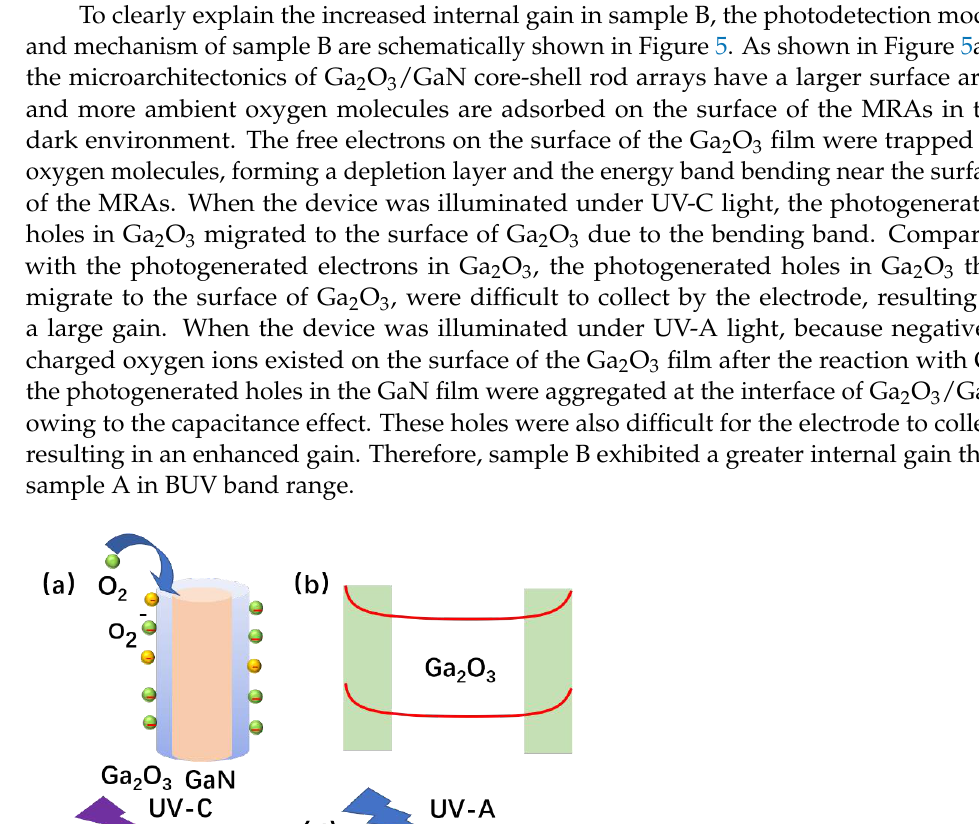
Figure 5. ( a , b ) Schematic of reaction of Ga 2 O 3 /GaN core-shell micron rod with oxygen and band of Ga 2 O 3 films after reaction with oxygen respectively ( c ) Schematic of holes transferred to the surface of Ga 2 O 3 film under UV-C illumination; ( d ) Schematic of photo-generated holes in GaN layer gath- ering at Ga 2 O 3 /GaN heterojunction interface owing to capacitance effect under UV-A